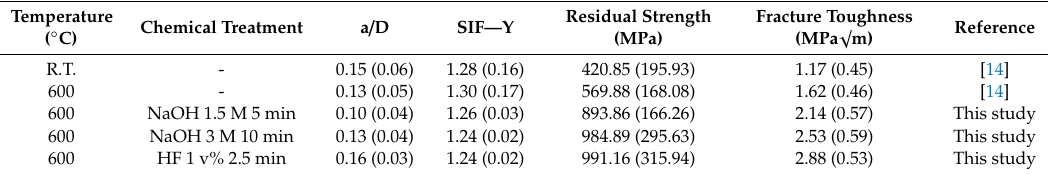
Table 3. Fracture characteristic values obtained after SENT tests of untreated, thermally conditioned and regenerated basalt fibres. The values include fibre notch depth/diameter ratio ( a/D ), geometric factor ( Y ), residual strength ( σ f ), fracture toughness ( K Ic ), expressed as average value of the investigated property (standard deviation).